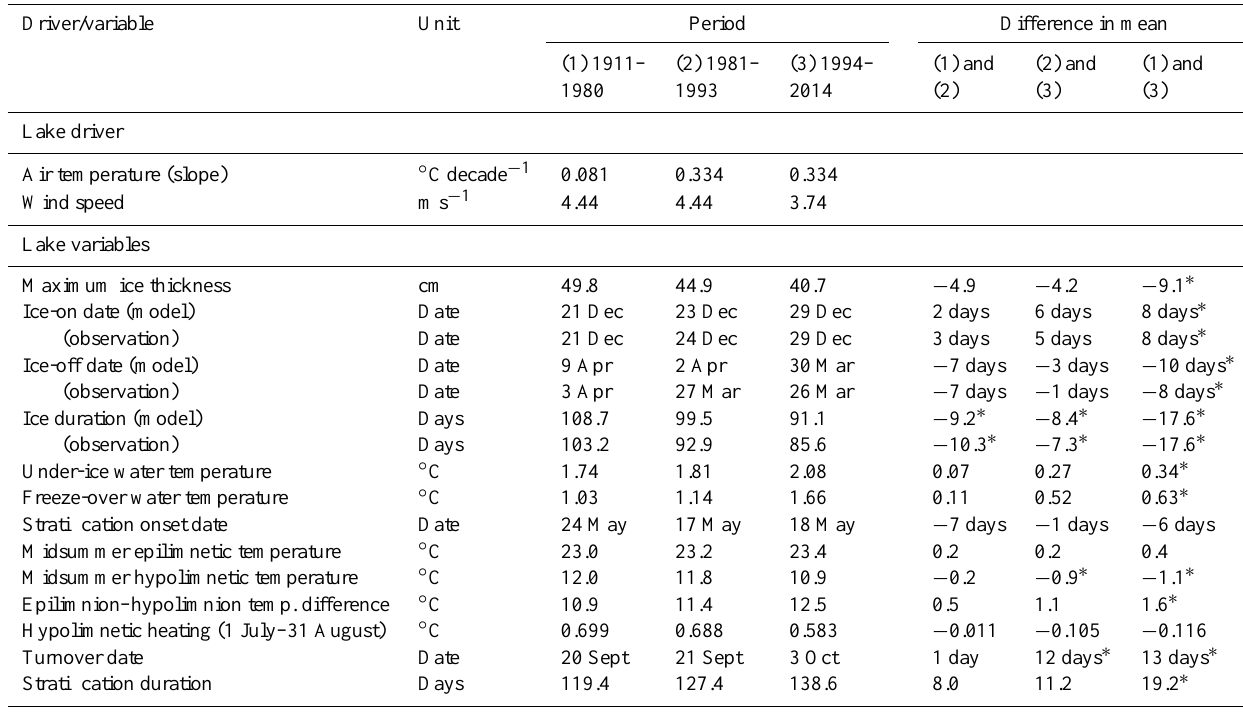
Table 2. Mean values of climate drivers and lake variables of three hypothesized periods during 1911–2014. Driver/variable